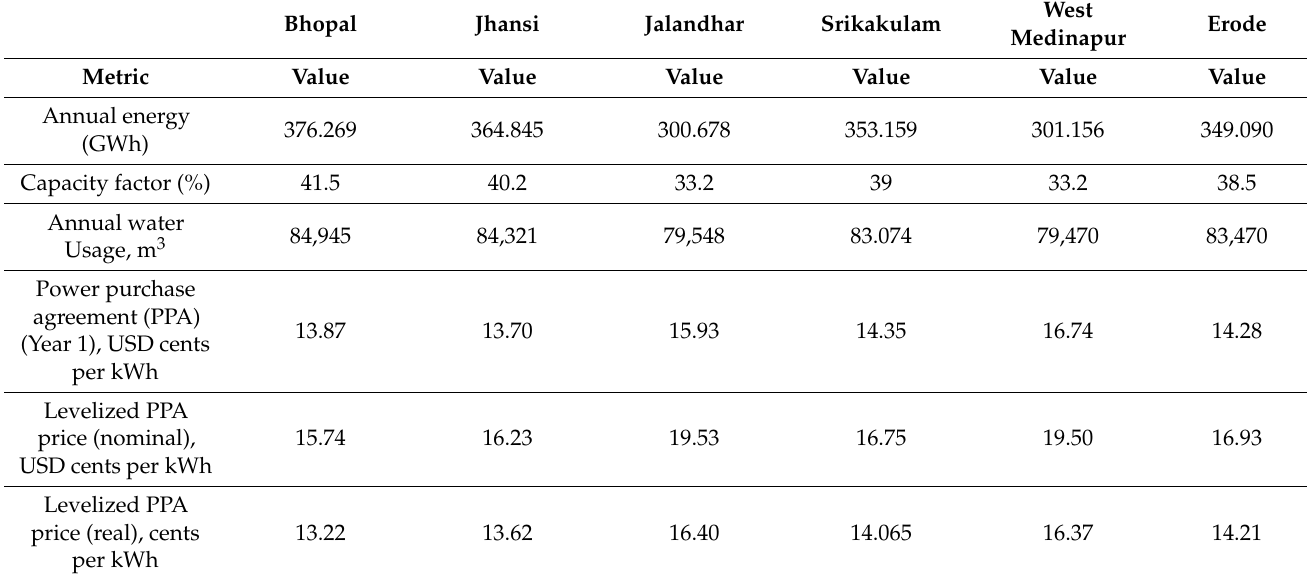
Figure 5. Total electric power output to grid (dry-cooled) for the six potential sites. Table 2. Economic results from the simulation in SAM for the STPP (dry-cooled) plant.